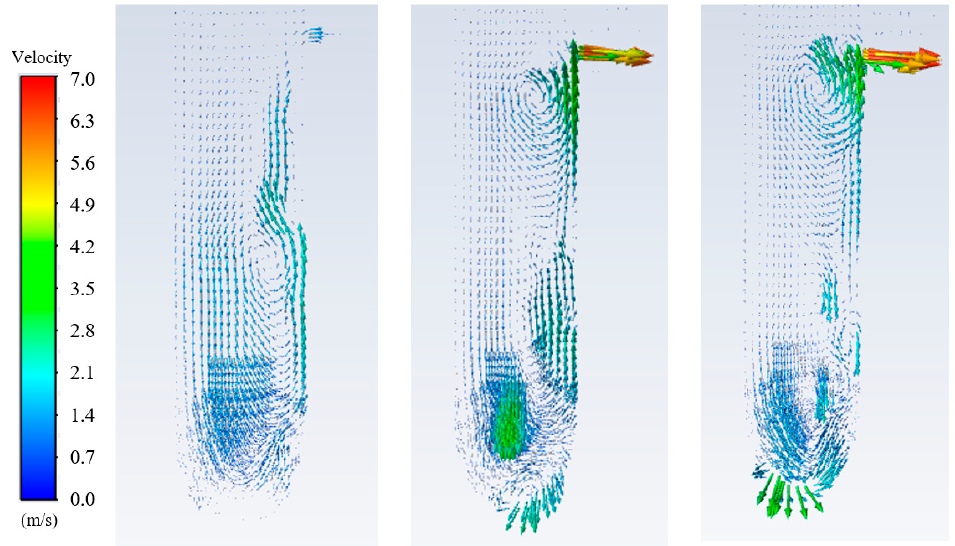
Figure 10. Velocity vector in the liquid-return hole and the suction pipe. s = 100% s = 50% s = 20%.